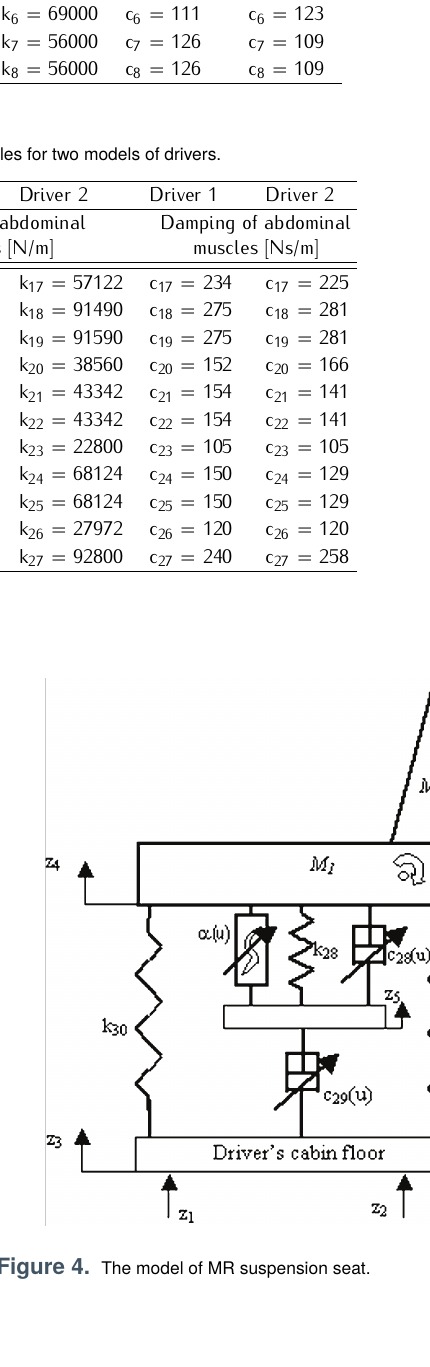
Fig. 4. The model of MR suspension seat. Figure 4. The model of MR suspension